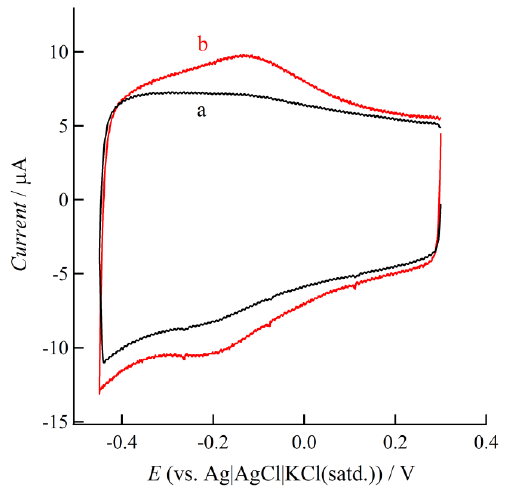
Figure 1. Cyclic voltammograms (CVs) of indium-tin-oxide (ITO) electrodes in ( a ) 39 mM phosphate buffered saline (PBS) (pH 7.4) and ( b ) 39 mM PBS (pH 7.4) containing 5 µM hemoglobin (Hb) solution. Sweep rate is 0.5 V s − 1